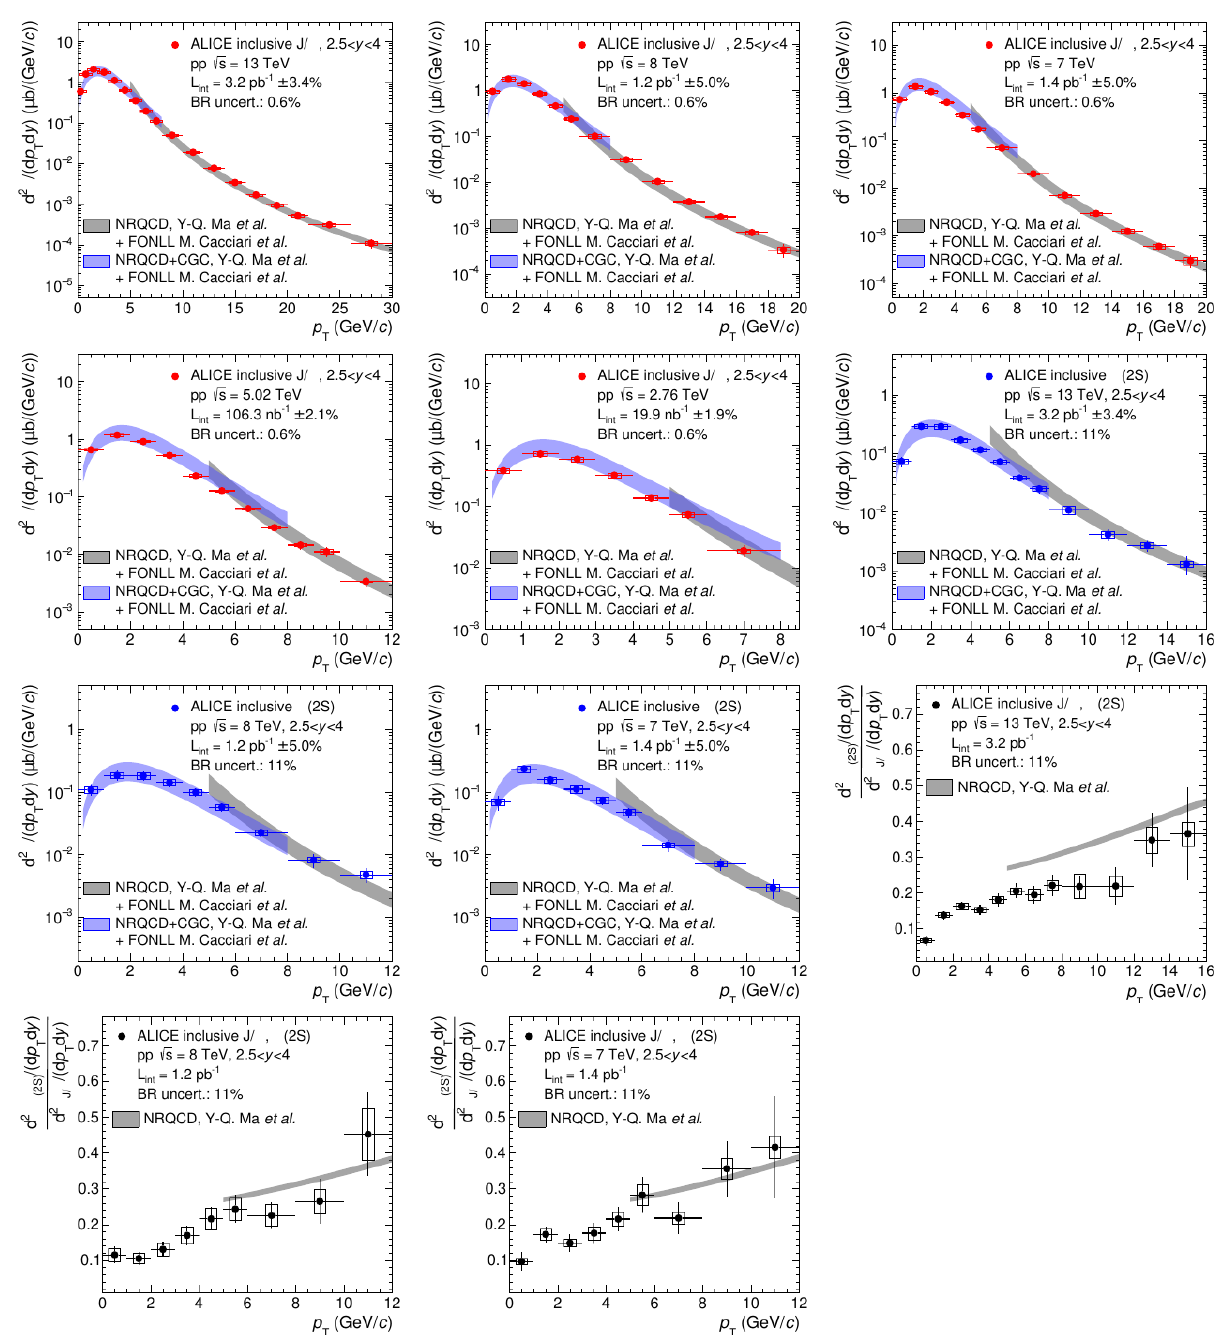
Figure 20. J / ψ and ψ ( 2 S ) at five center of mass energies from the ALICE experiment compared to summed CGC-NRQCD and FONLL calculations